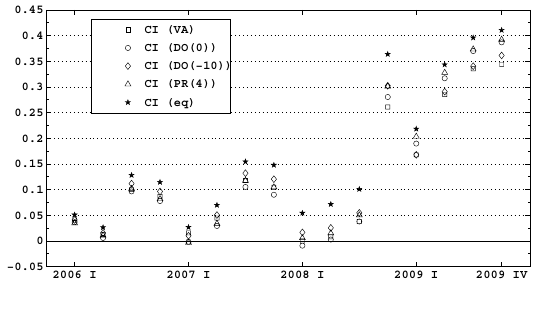
Figure 4. CI differences from GDP